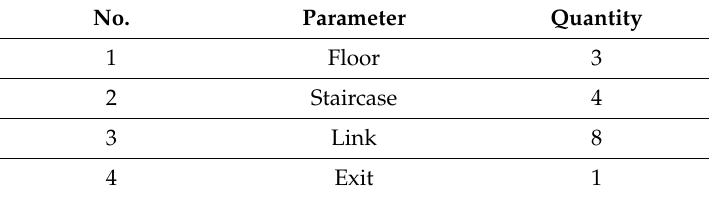
Table 4. Parameter settings of the simulation model.